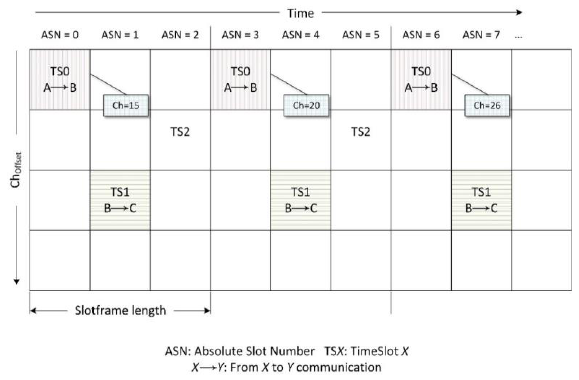
Figure 1. The timeslot and channel offset matrix used in the Time-Slotted Channel Hopping (TSCH) method.